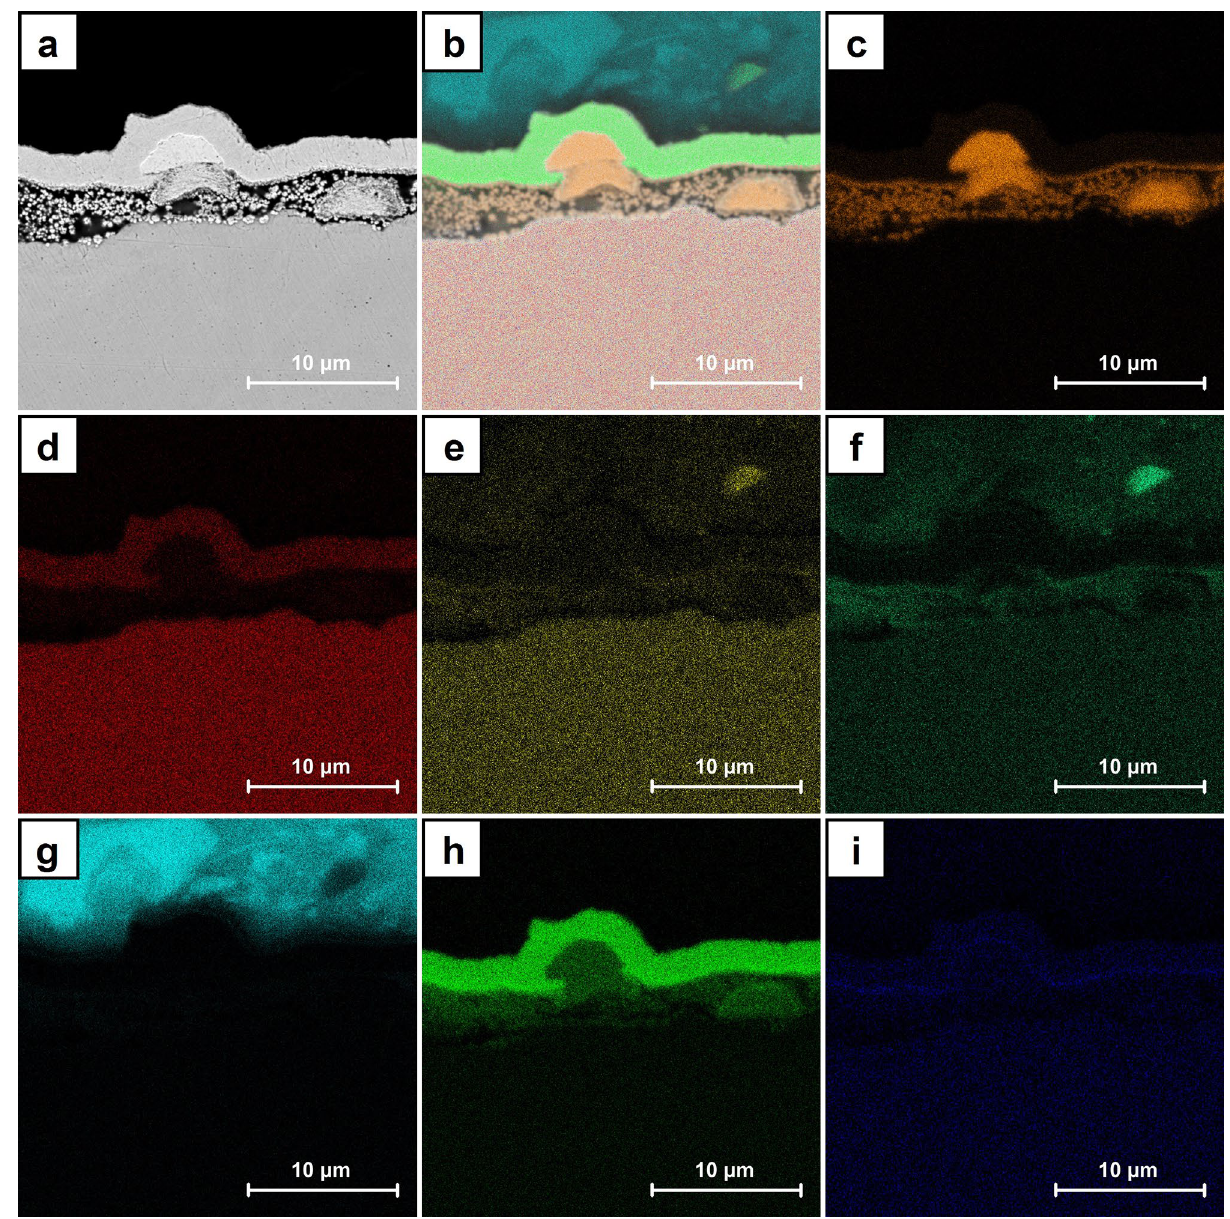
Figure 14. SEM images of B7 sample (ECD deposition time of 600 s, CuSO 4 concentration of 100 mM): cross section ( a ), cross section with elements distribution ( b ), single element distribution ( c – i ) including copper ( c ), iron ( d ), chromium ( e ), oxygen ( f ), carbon ( g ), nickel ( h ) and gold ( i